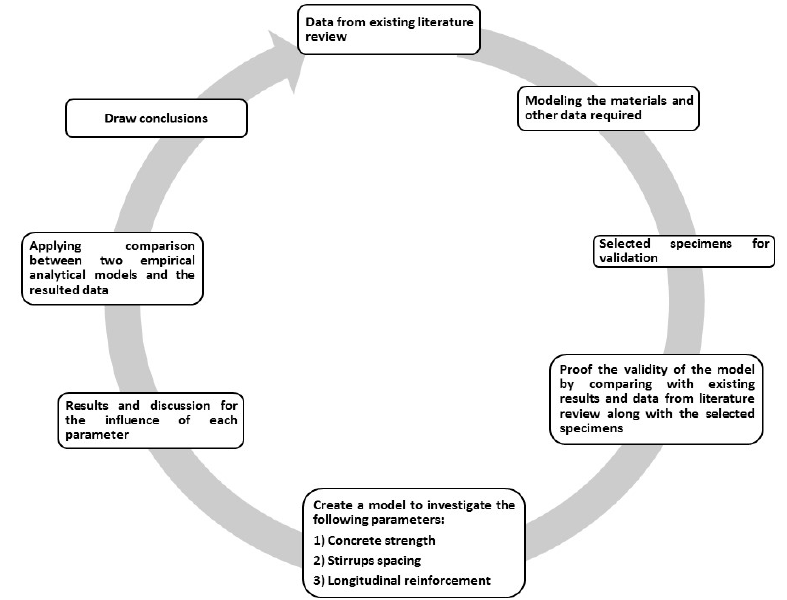
Figure 1. Typical schematic flowchart shows the sequence of the methodology adopted here in this study.